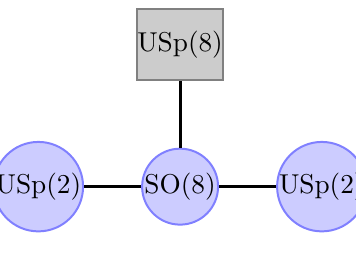
Figure 2 . The orthosymplectic quiver.